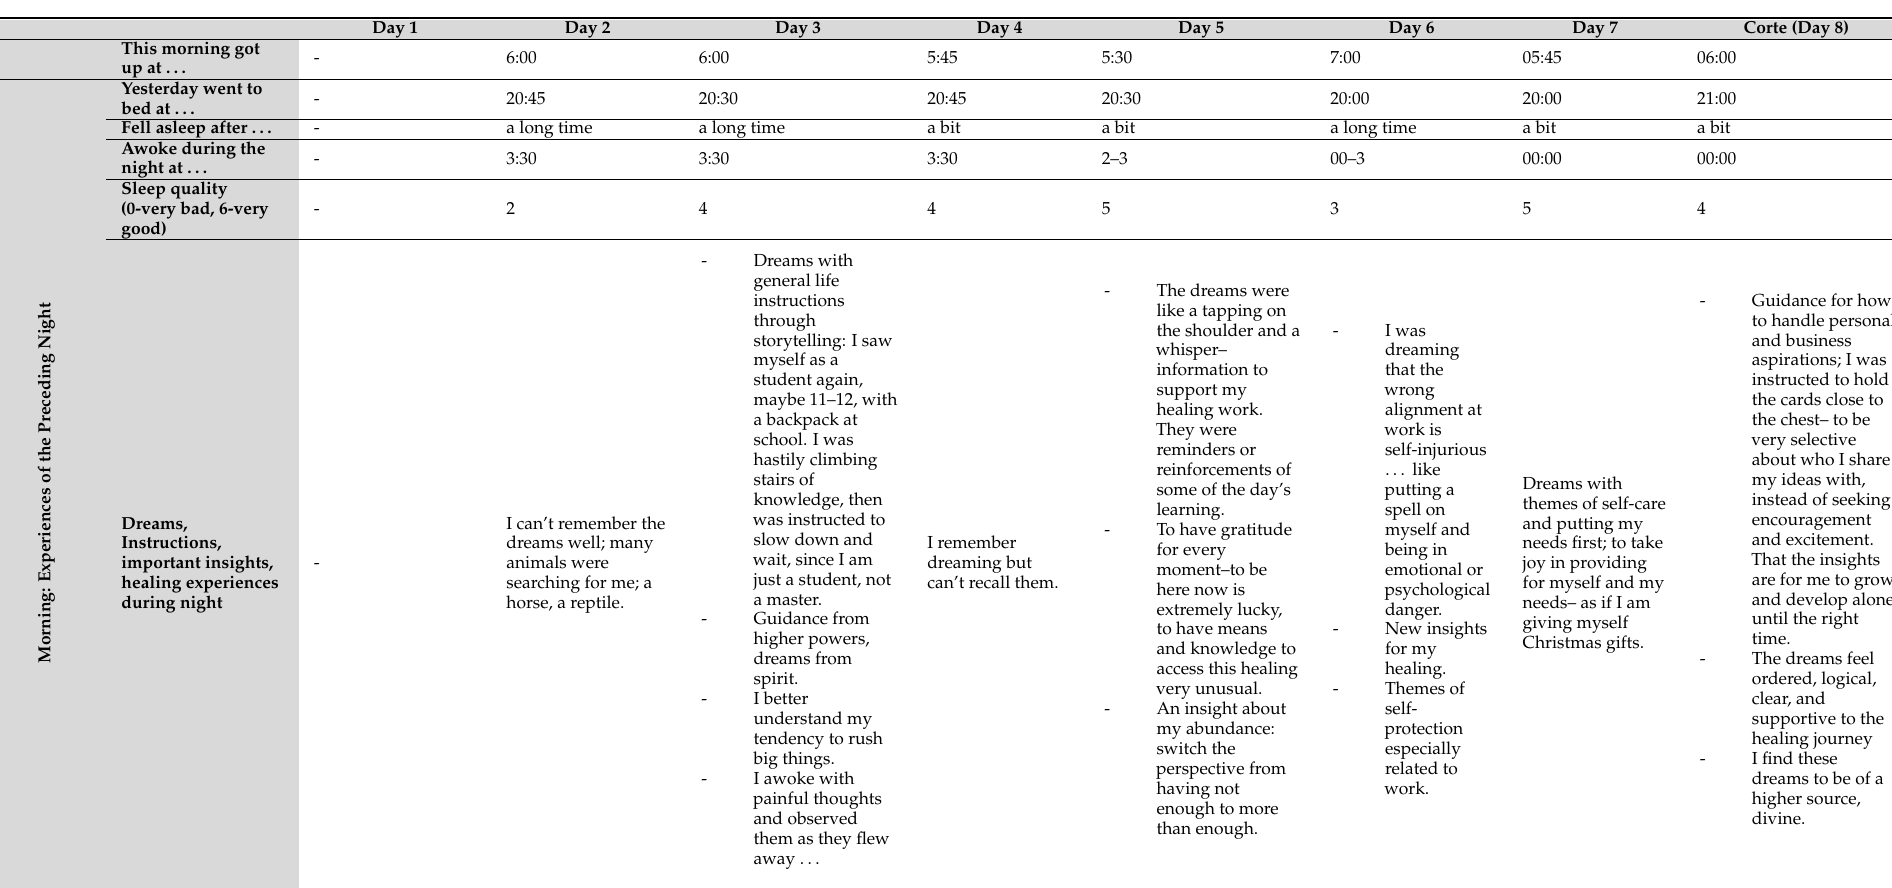
Table 3. Ecological momentary assessment (experience-sampling) during the treatment week. Day 1 Day 2 Day 3 up at